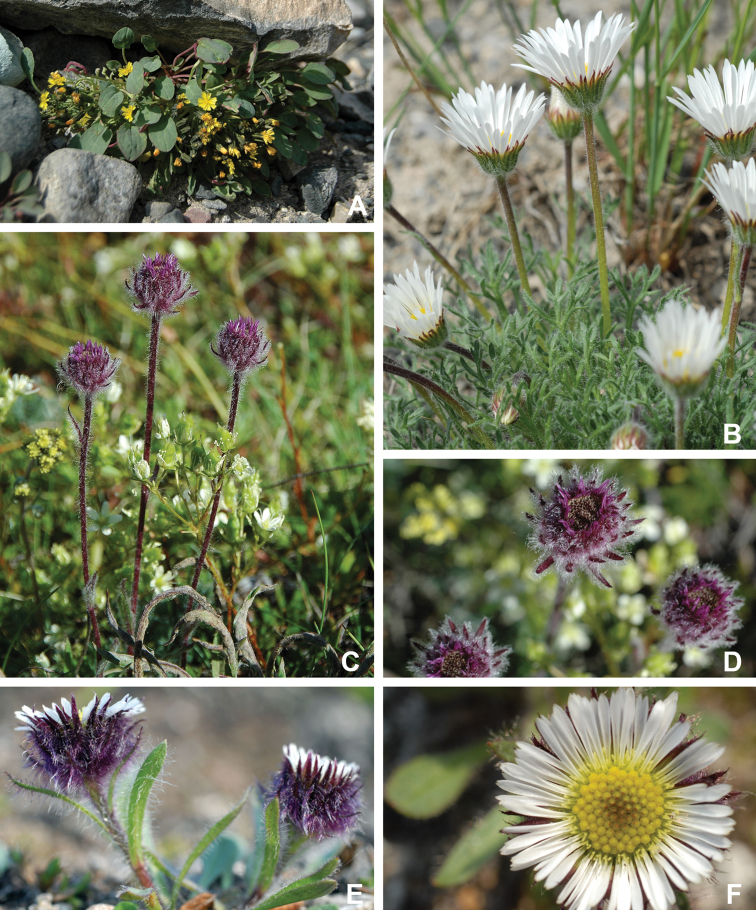
AAskellia
pygmaea habit, Gillespie et al. 10087BErigeron
compositus habit, Gillespie et al. 9832CErigeron
eriocephalus habit, Gillespie et al. 10189DErigeron
eriocephalus inflorescences, Gillespie et al. 10189EErigeron
humilis habit, Gillespie et al. 8087FErigeron
humilis inflorescence, Gillespie et al. 8087. Photos A, C–F by R.D. Bull and B by L.J. Gillespie.